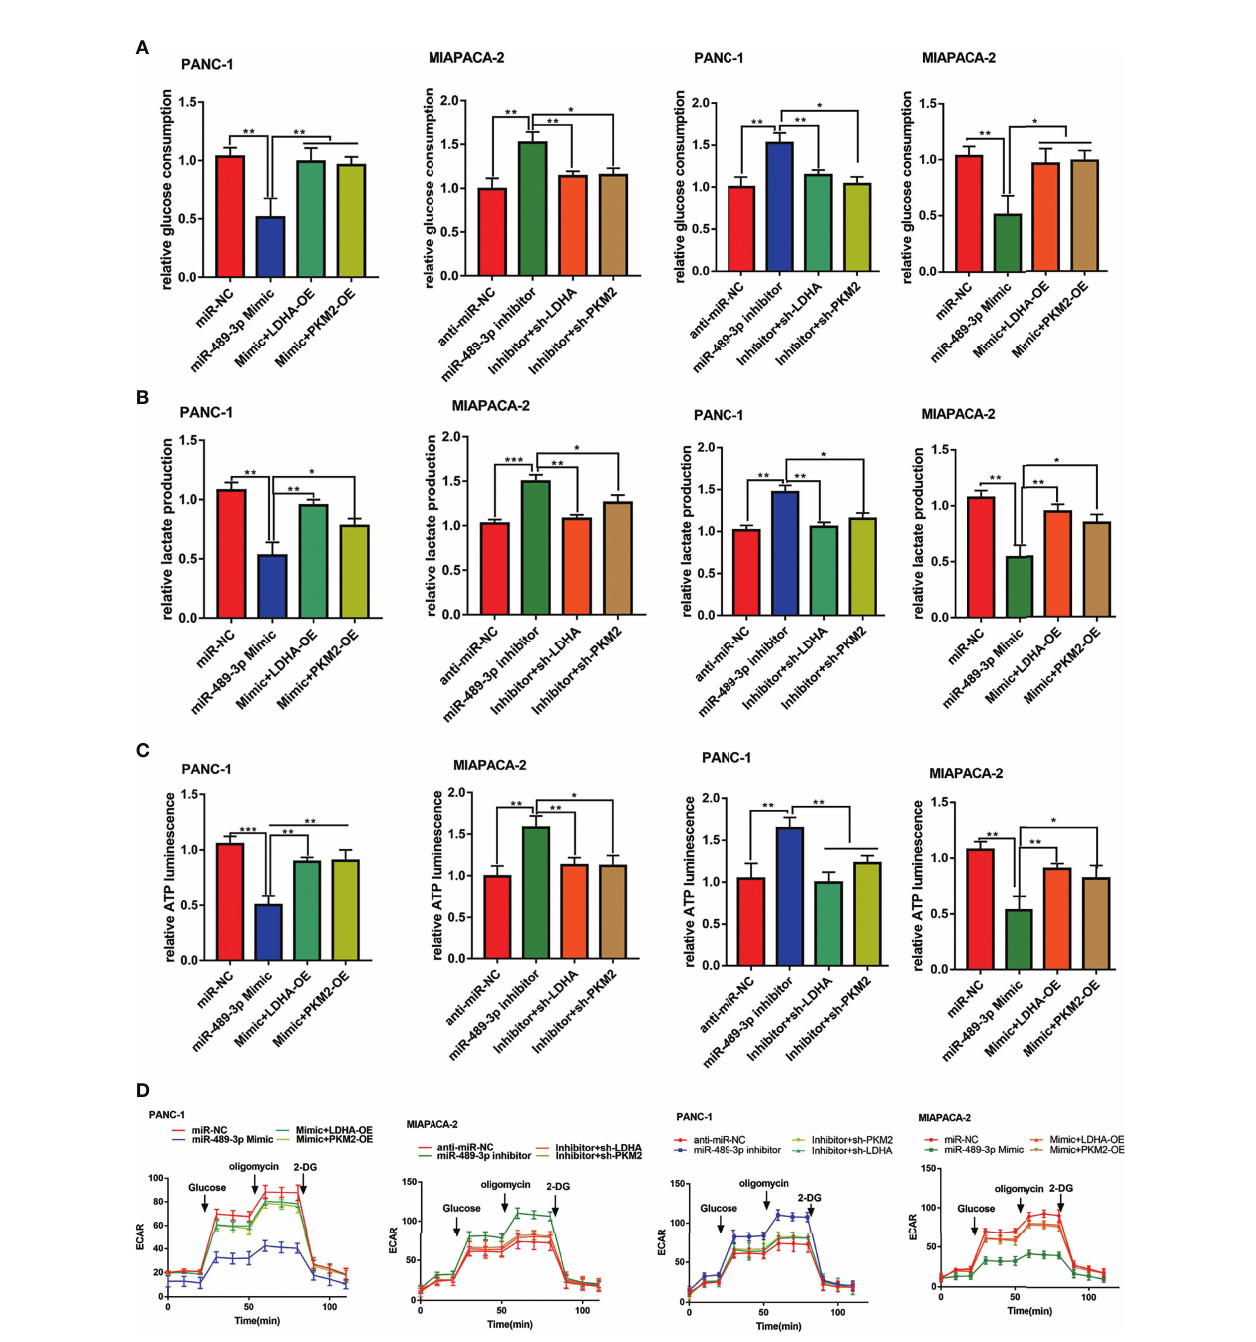
FIGURE 6 | MiR-489-3p suppresses glycolysis through LDHA and PKM2. (A – C) Cell metabolism experiments showed that glucose uptake, lactic acid production, and ATP production of PC cells transfected with miR-489-3p mimic, inhibitor, LDHA, PKM2 overexpressed plasmid or shRNA. (D) The hippocampal XF extracellular fl ux analyzer analysis of the PC ECAR after transfected with miR-489-3p mimic, inhibitor, LDHA, PKM2 overexpressed plasmid or shRNA. (*P < 0.05, **P < 0.01, ***P <